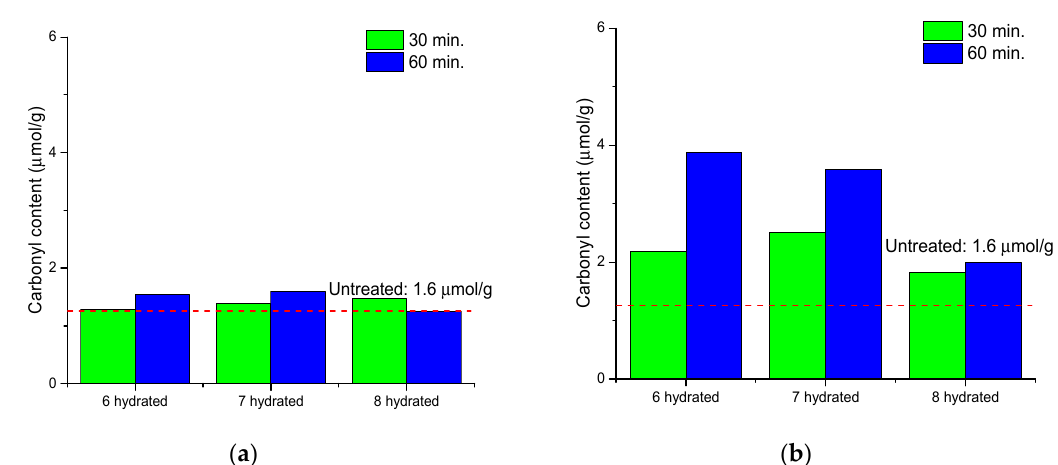
Figure 6. Carbonyl content of cellulose after dissolving as a function of the number of hydrates in calcium thiocyanate at 100 °C ( a ) and 120 °C ( b ).